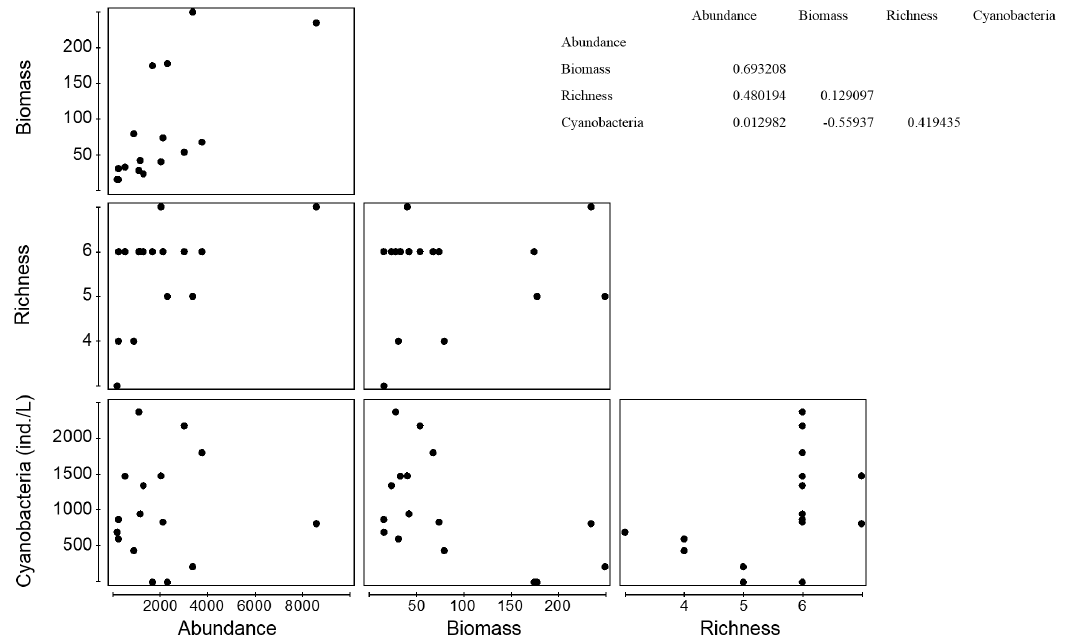
Figure 2. Series of bivariate correlations (Draftsman plot). Spatial representation of the distribution of structural at- tributes (abundance, biomass and richness) of rotifers in relation to density of Cyanobacteria in the Poções Reservoir, Paraíba River basin, State of Paraíba, Brazil. On the right side, data of the series of bivariate correlation.